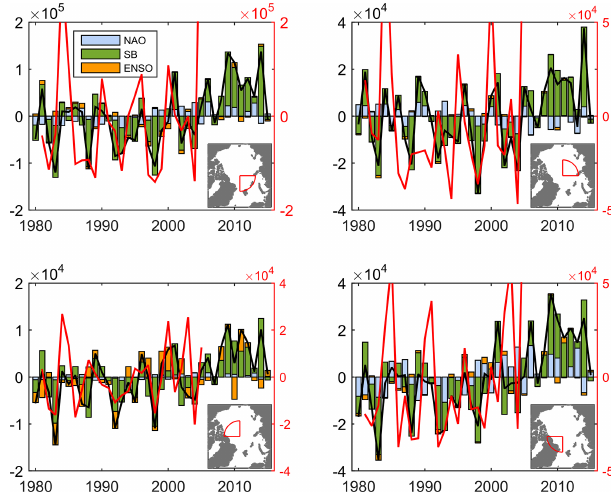
Figure 8. Temporal variability of total BC wet deposition anomaly over 90 ◦ longitude segments of the Arctic and between 80 and 90 ◦ N (kgyr − 1 ) related to the circulation patterns IC NAO , IC SB and IC ENSO . The black line is the sum of the three components; the red line (right y axis) is the total BC wet deposition anomaly from the FIX2000 simulation.